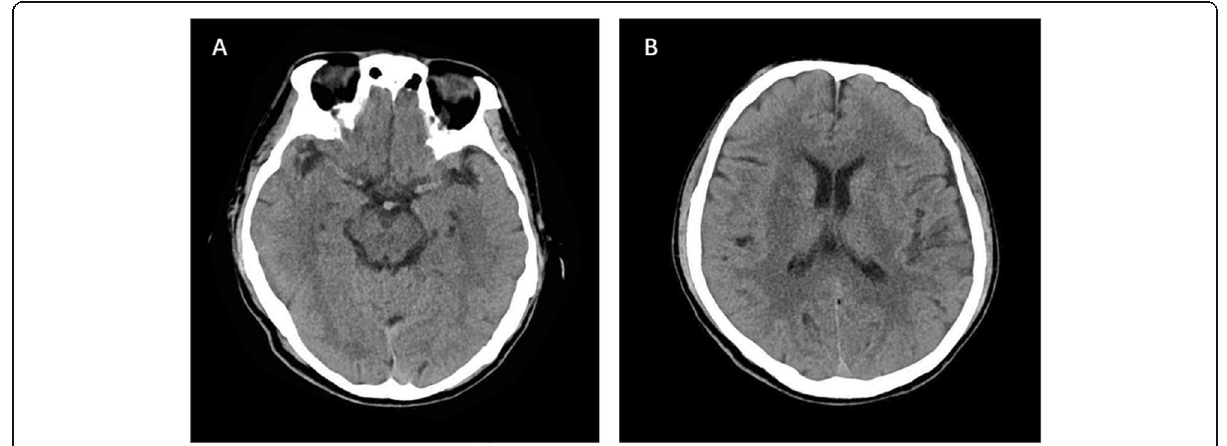
Fig. 1 Brain CT images at different cross sections ( a & b ), which indicated lacunar cerebral